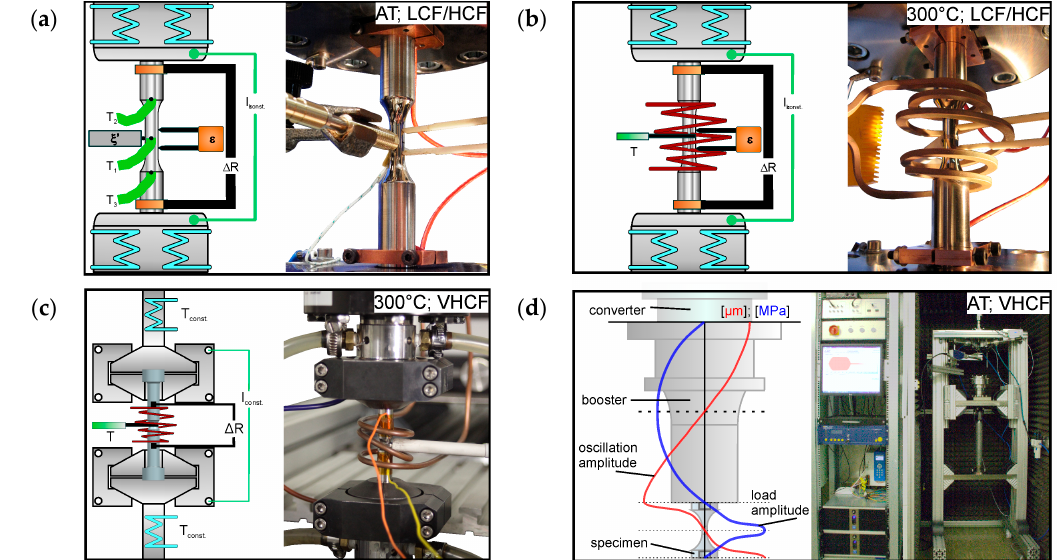
Figure 3. Schematic representation of the experimental setup for fatigue tests in the LCF and HCF regime at ( a ) AT and ( b ) at T = 300 °C, as well as in the VHCF regime at ( c ) T = 300 °C and ( d ) at AT.